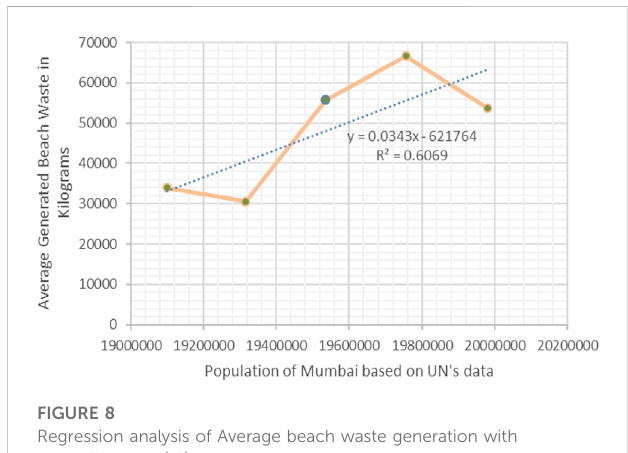
FIGURE 8 Regression analysis of Average beach waste generation with respect to population.